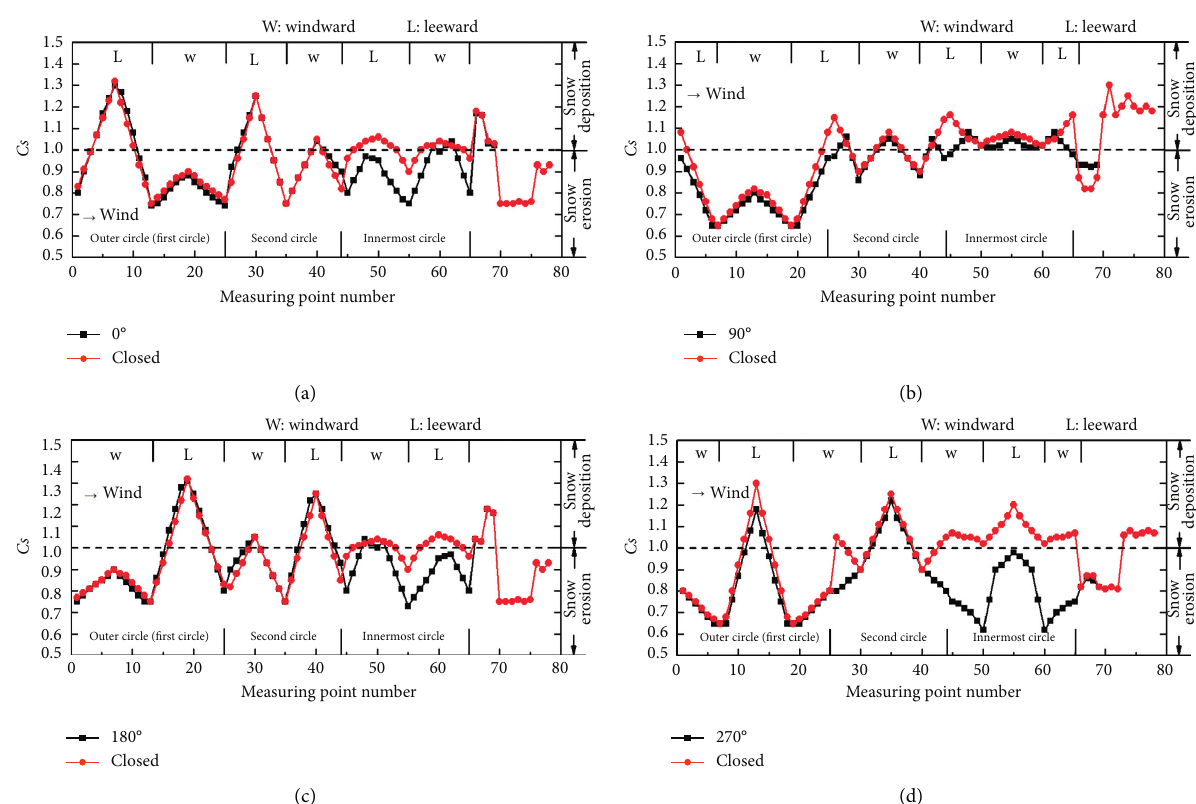
Figure 12: Comparison of the snow distribution on the surfaces of an open stadium for different opening directions and a closed stadium. (a) 0 ° . (b) 90 ° . (c) 180 ° . (d) 270 °